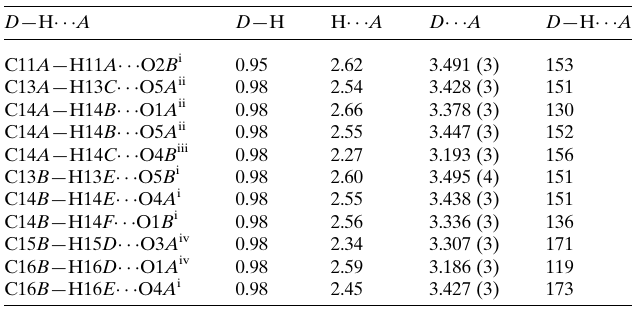
Table 2 Hydrogen-bond geometry (A˚ , (cid:2)